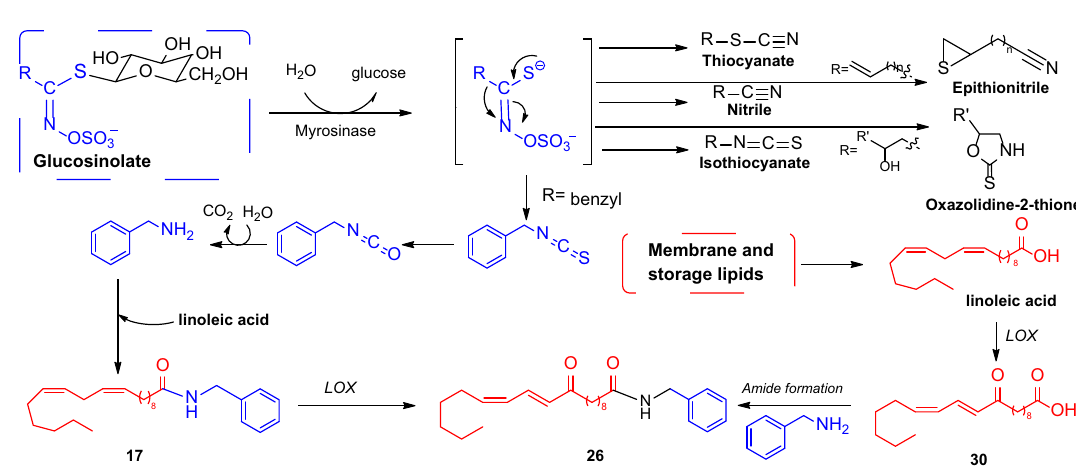
glucotropaeolin (1): R 1 =R 2 =H glucolepigramin (2): R 1 =H, R 2 =OH glucolimnanthin (3): R 1 =H, R 2 =OMe glucosinalbin (4): R 1 =OH, R 2 =H glucoaubrietin (5): R 1 =OMe, R 2 =H Fig. 1 Structures of glucosinolates found in